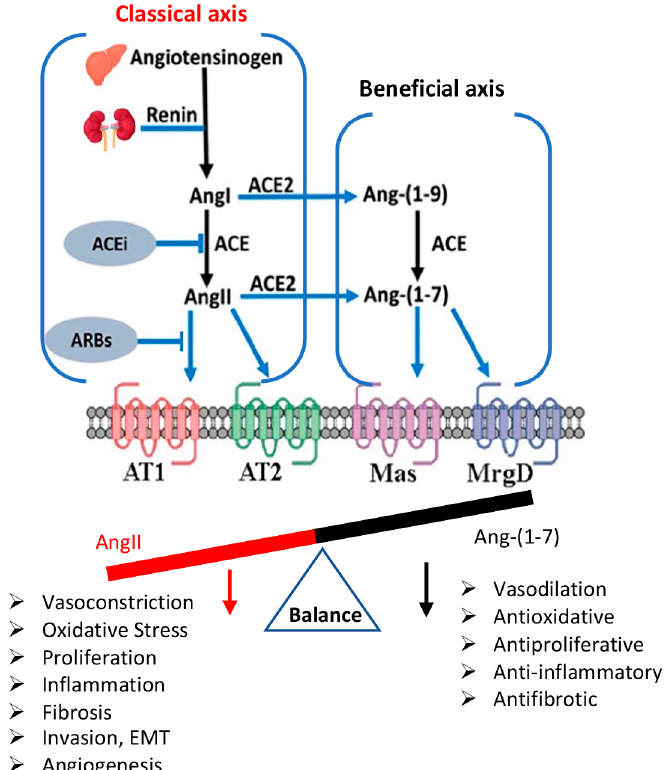
Figure 1. The classical and beneficial arms of RAS. Angiotensinogen is produced by the liver, then hydrolyzed by renin to form angiotensin I (AngI). Next, Ang I is hydrolyzed by angiotensin-converting enzyme (ACE) to produce the octapeptide angiotensin II (AngII). AngII can stimulate two receptors, AngII type 1 receptor (AT1) and AngII type 2 receptor (AT2). ACE2 catalyzes Ang II to generate the heptapeptide angiotensin-(1-7) (Ang-(1-7)), which can also be a product of ACE activity cleaving angiotensin-(1-9) (Ang-(1-9)). Ang (1-7) counteracts the effects of AngII by interacting with the receptors Mas (Mas) and/or MrgD.